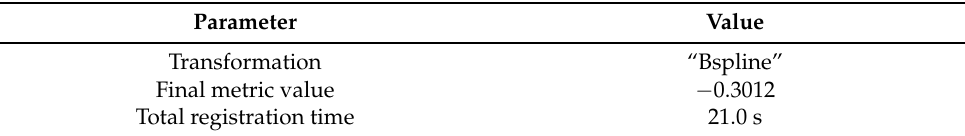
Table 8. Result of one slice elastic registration using SimpleITK.